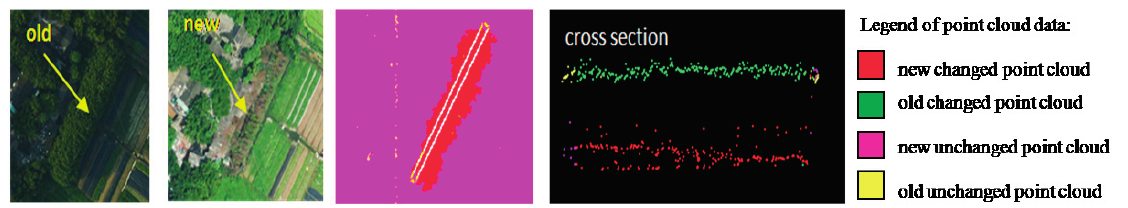
Figure 9. Details of flat treetops ( first column : old orthophoto; second column : new orthophoto; third column : superposition of the old and new point clouds; fourth column : cross-section of the yellow rectangle area in the third column; fifth column : legend of the point cloud data).